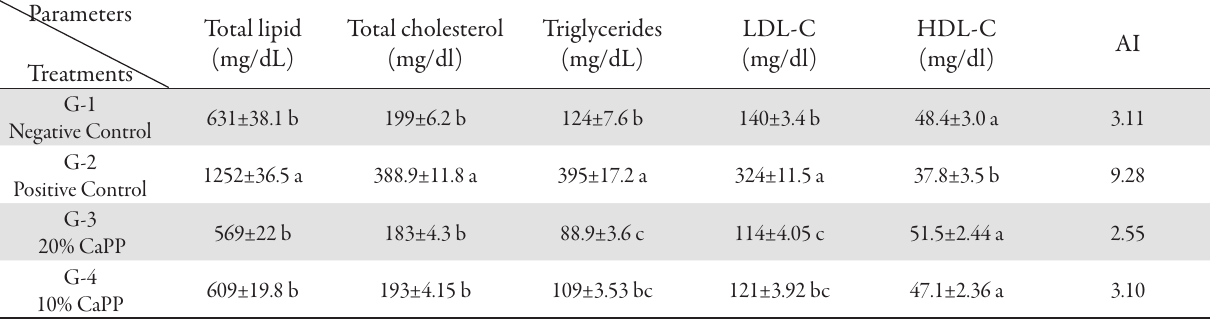
Tab. 3. Plasma total lipid, total cholesterol, triglycerides, LDL-C, HDL-C (mg/dl) and AI in the experimental rats Parameters